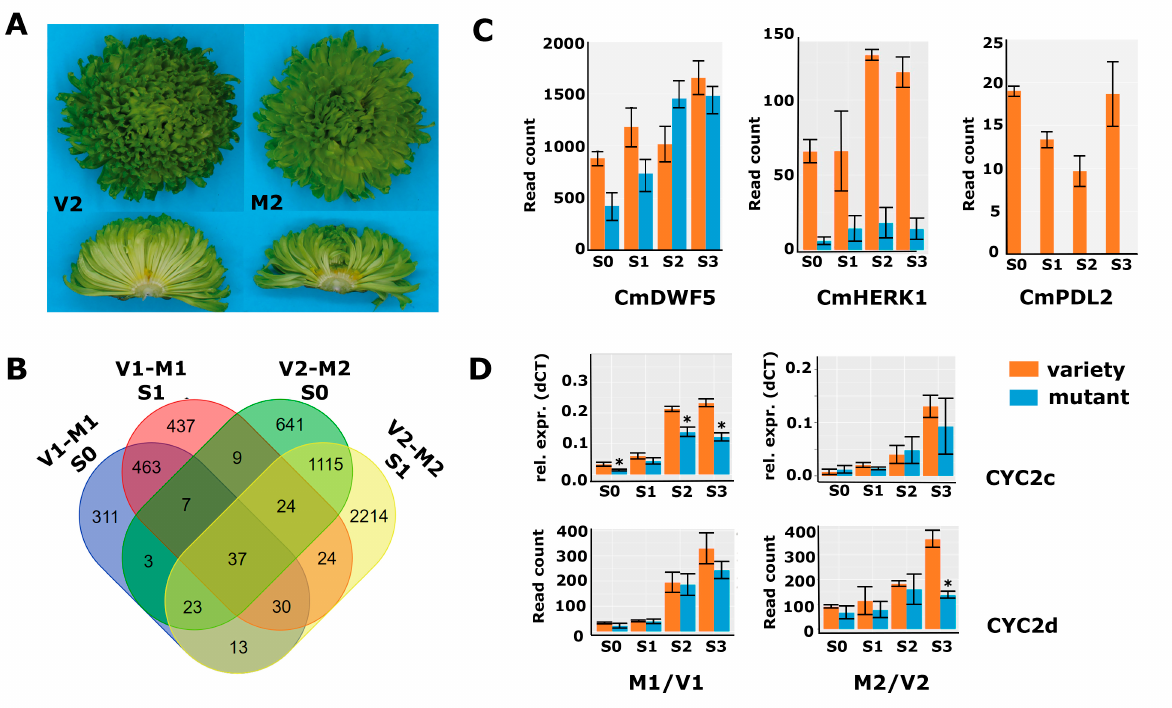
Figure 3. DEG analysis in a second genetic background. ( A ) Pictures of variety 2 (left panels) and mutant 2 (right panels) of a complete inflorescence (top) and transversely sectioned inflorescence (bottom). ( B ) Overlap of DEGs between V1/M1 and V2/M2 in stages 0 and 1. ( C ) Read count data from the second RNA-seq experiment (V2/M2) for CmDWF5 (DN57668), CmHERK1 (DN68032), and CmPDL2 (DN38497). ( D ) qPCR data for CYC2c and read count data for CYC2d from both RNA-seq experiments (V1/M1 left; M2/V2 right). Error bars indicate SE; asterisks indicate significance (qPCR: p < 0.05; RNA-seq: Padj < 0.01).